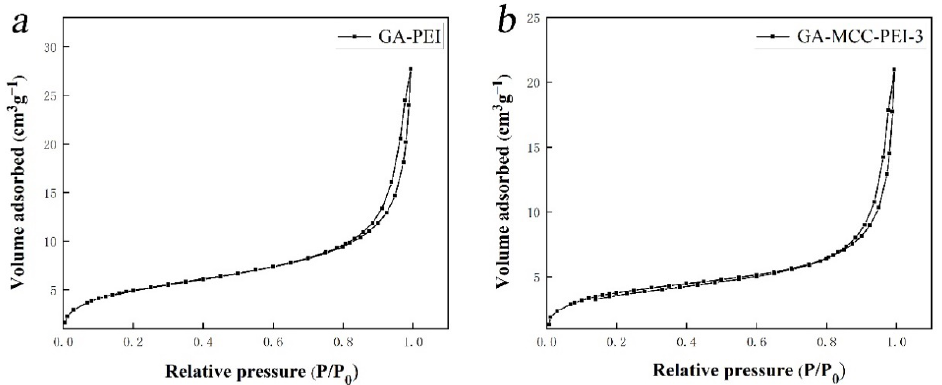
Figure 2. Brunauer–Emmett–Teller (BET) isotherms of ( a ) GA-PEI aerogel and ( b ) GA-MCC-PEI-3 aerogel for the determination of pore structure.